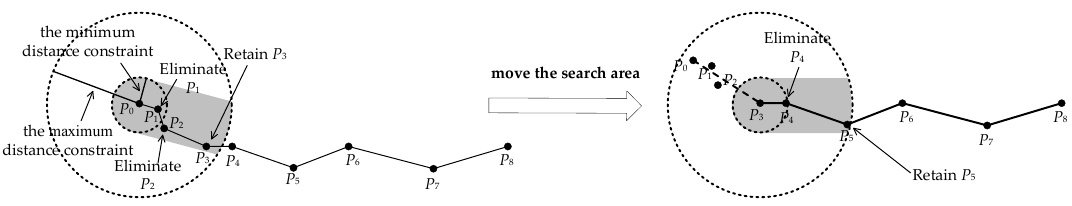
Figure 10. T he Opheim algorithm for polyline simplification. Figure 10. The Opheim algorithm for polyline